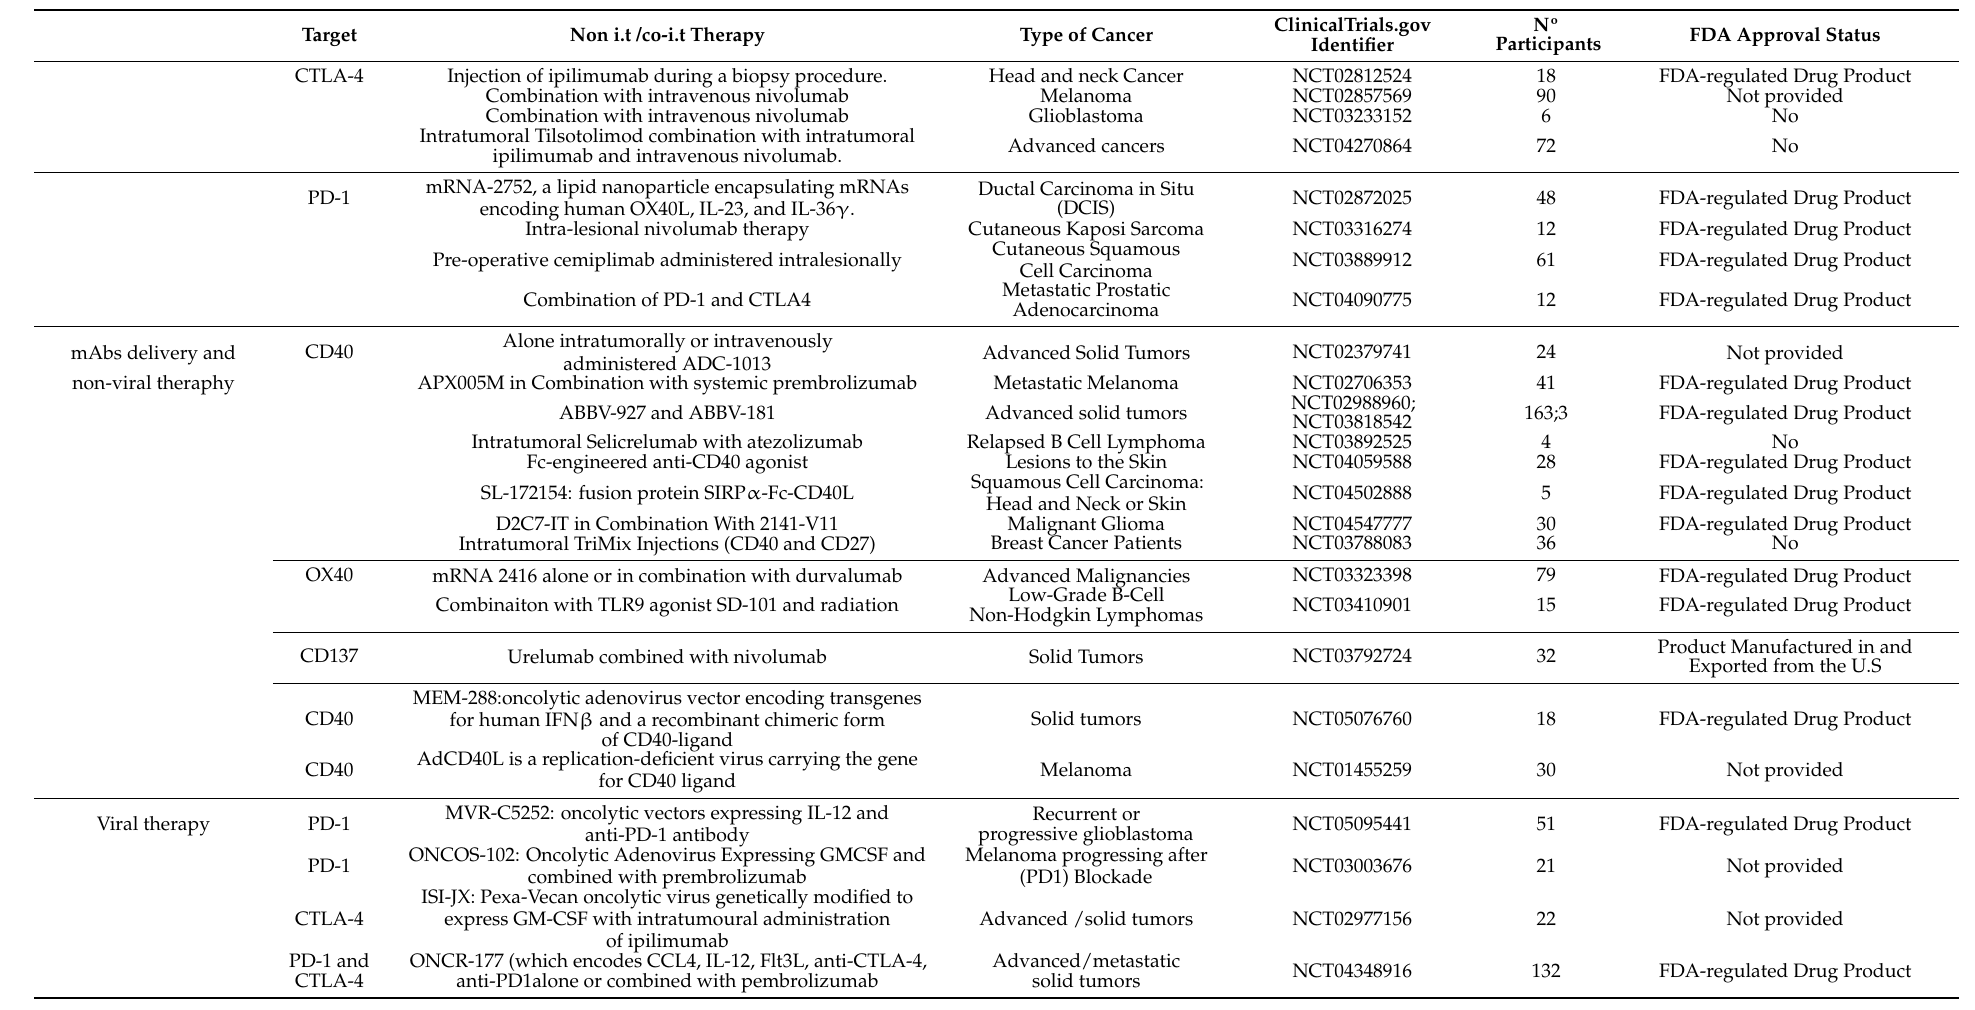
Table 3. Ongoing trials of intratumoral mAbs